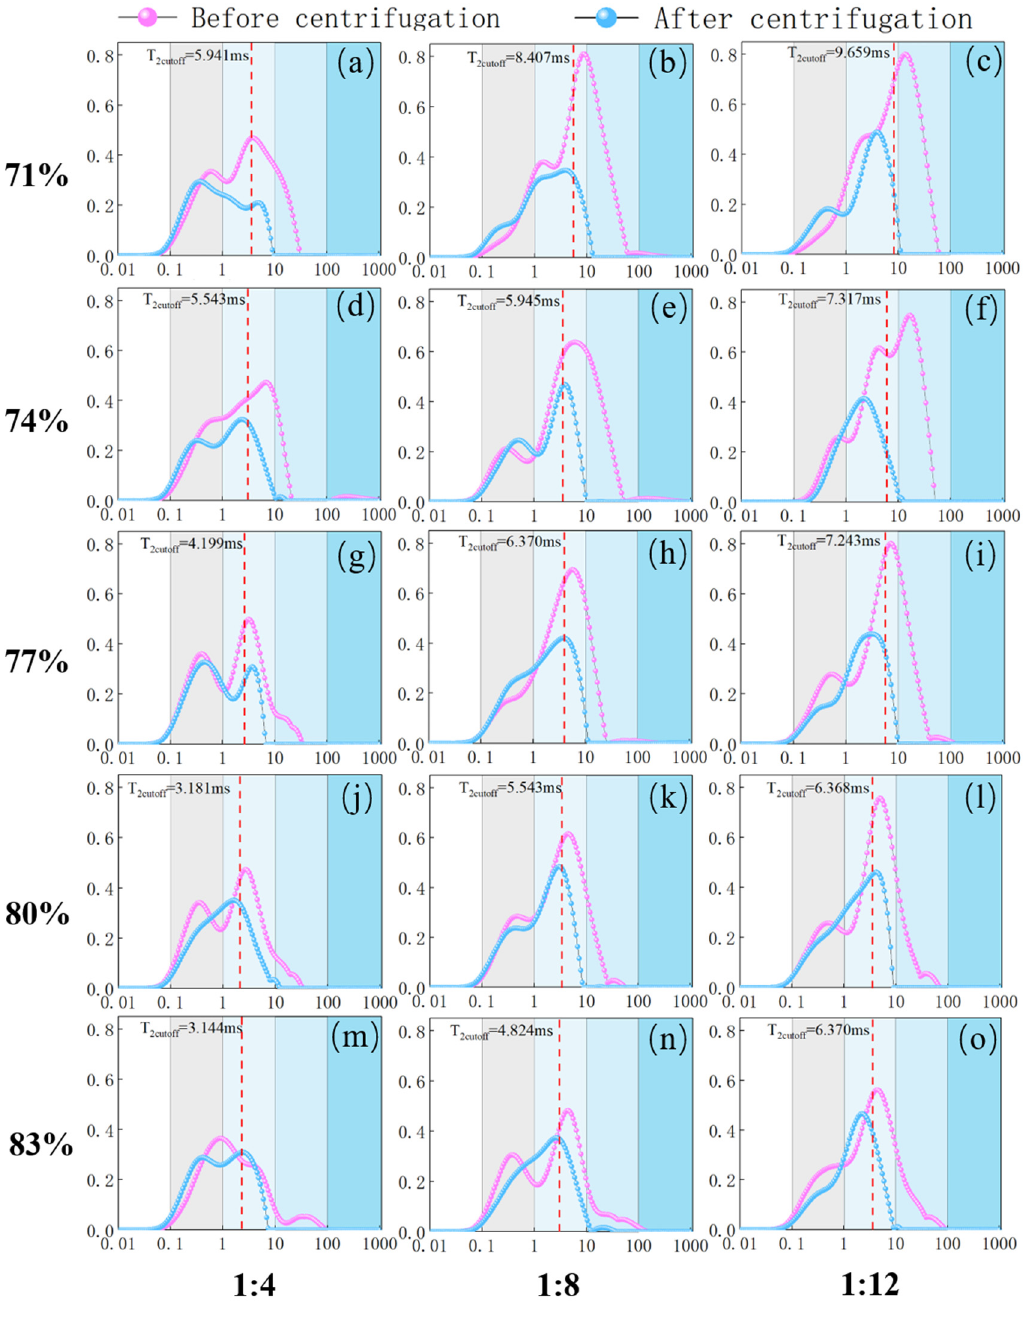
Figure 8. Analysis of the porosity components of backfills with different concentrations and ratios before and after centrifugation (the horizontal axis is the T 2 relaxation time, and the vertical axis is the porosity component). ( a )–( o ) represent data of backfills with different cement–tailings ratio and solid mass concentration